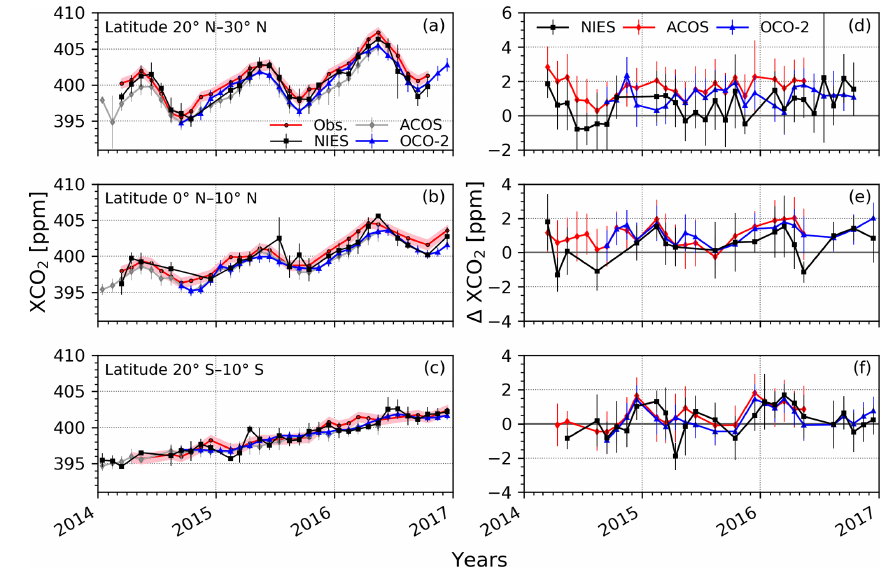
Figure 5. Temporal variation of the satellite-derived XCO 2 obtained by NIES (black), ACOS (gray), and OCO-2 (blue) in comparison with the obs. XCO 2 (red) (a, b, c) , and the difference between obs. XCO 2 and NIES (black), ACOS (red), and OCO-2 (blue) (d, e, f) for three selected latitude boxes. Red-shaded areas are the uncertainty of the obs. XCO 2 which was derived from the ± 2ppm variability in the observation-based CO 2 profile at ∼ 850hPa. Error bars show the standard deviation of the monthly averaged XCO 2